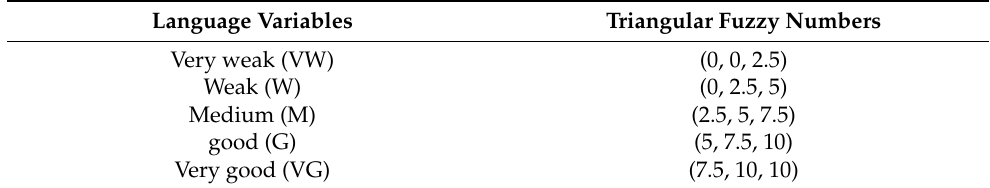
Table 3. Language variables and corresponding triangular fuzzy numbers for the ranking of the enterprises to be